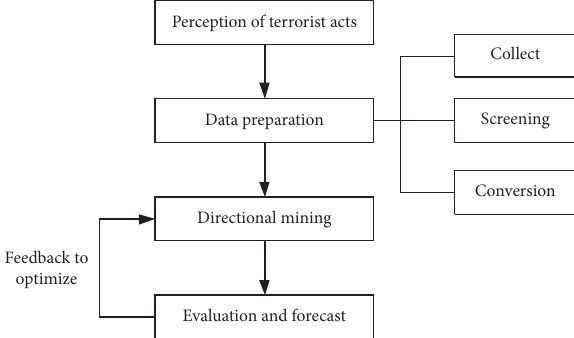
Figure 3: The whole idea of traditional antiterrorism prediction